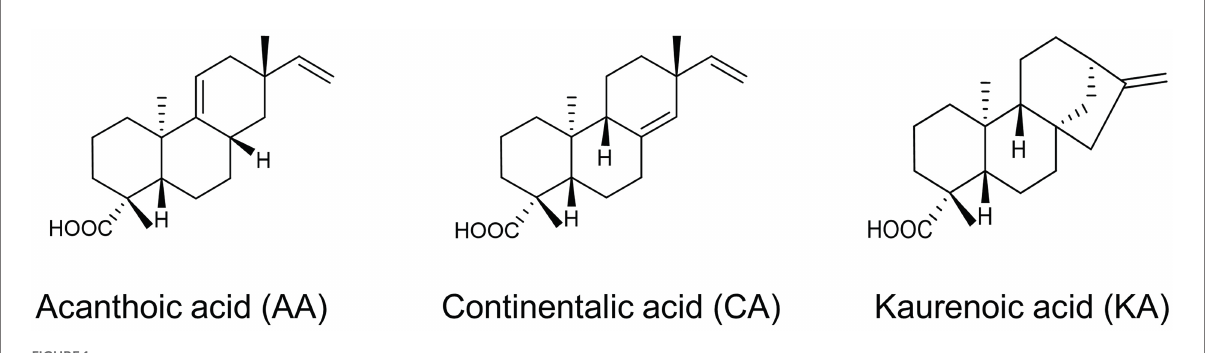
FIGURE 1 Antibacterial compounds derived from Aralia